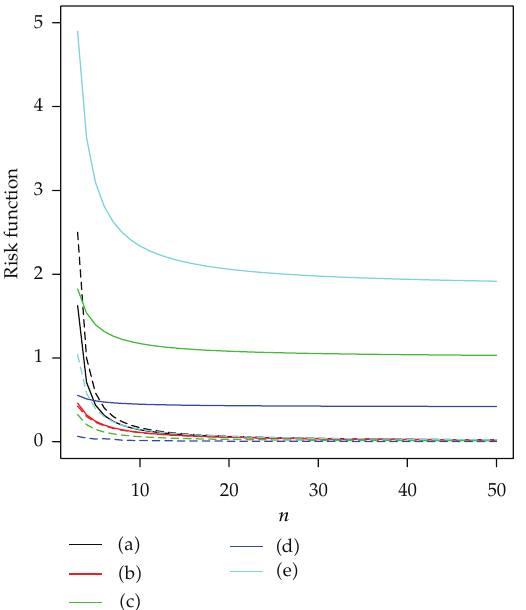
Figure 5: Risk function of estimators under conjugate prior for di ff erent n